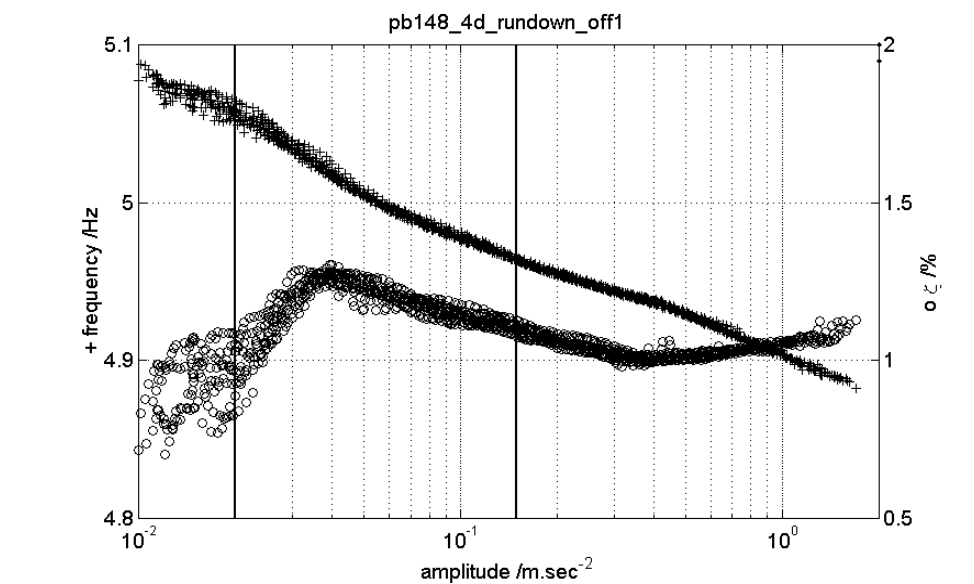
Fig. 5. Frequency ( + ) and damping (o) estimates from free decay of mode V1 without human occupation. Solid vertical lines indicate bounds on normal pedestrian-induced